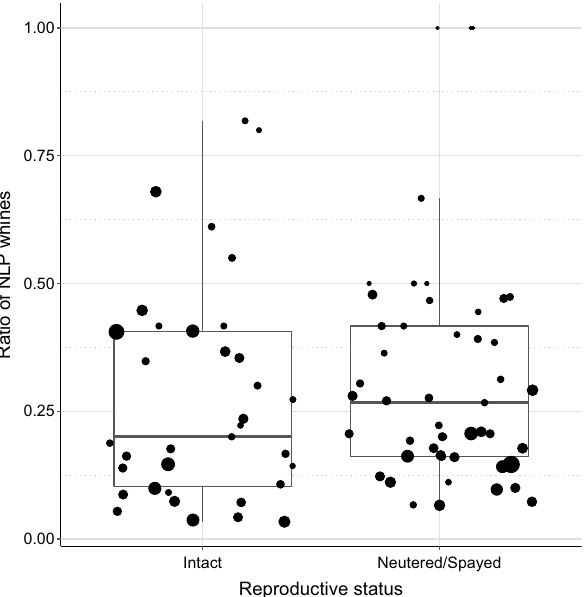
Figure 4. The effect of reproductive status on NLP ratio. Neutered/spayed dogs produce more whines containing NLP. The horizontal line within the box shows the median, the boxes represent the interquartile intervals, the whiskers the range. The size of the dots is proportional with the number of whines produced.